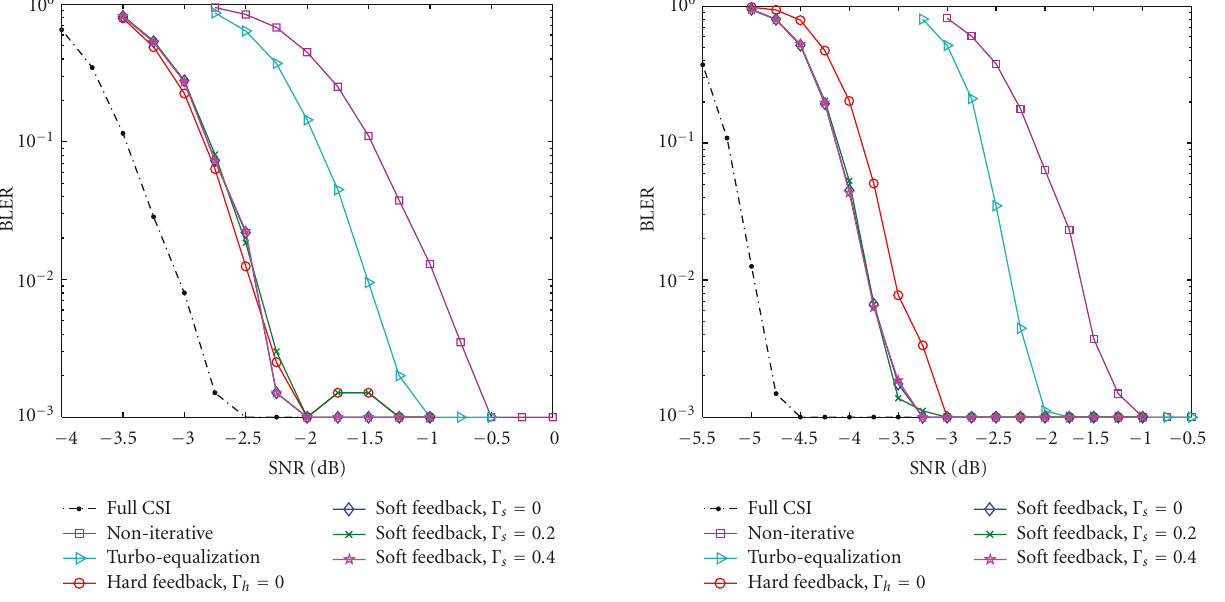
Figure 3: Simulation results, N t = 2, N r = 4, QPSK.